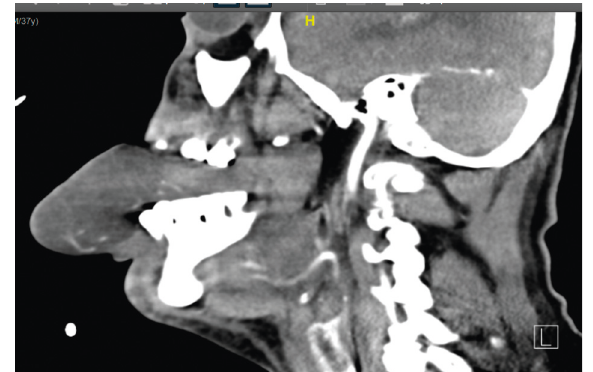
Figure 3: Sagittal cross section of a soft-tissue window computed tomography image with a tongue protrusion far beyond the lower